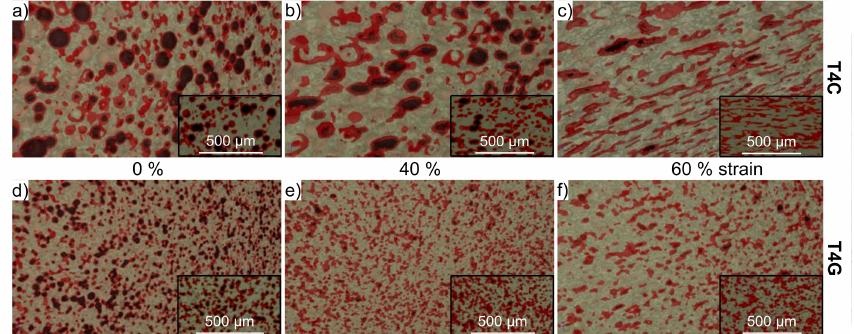
Figure 8. Structure evolution of the TRIP-steel syntactic foams under quasi-static compression: ( a – c ) with 40 vol % Fillite 106 cenospheres (T4C); ( d – f ) with 40 vol % S60HS glass microspheres (T4G); pale grey—matrix, red—sphere shells/inclusions, black—cavities/pores. (Load direction is